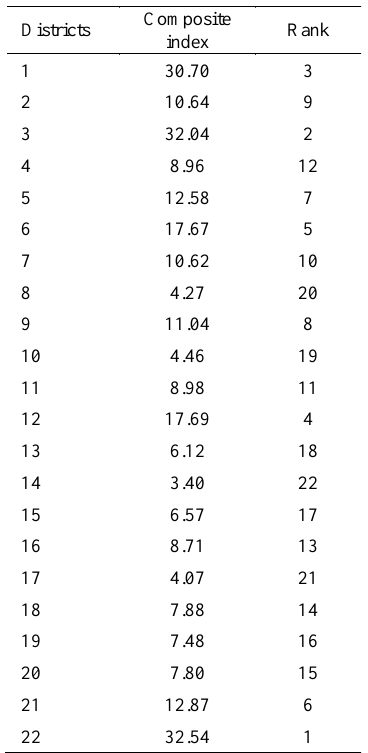
Table 4: Ranking of districts of Tehran, using factor Districts